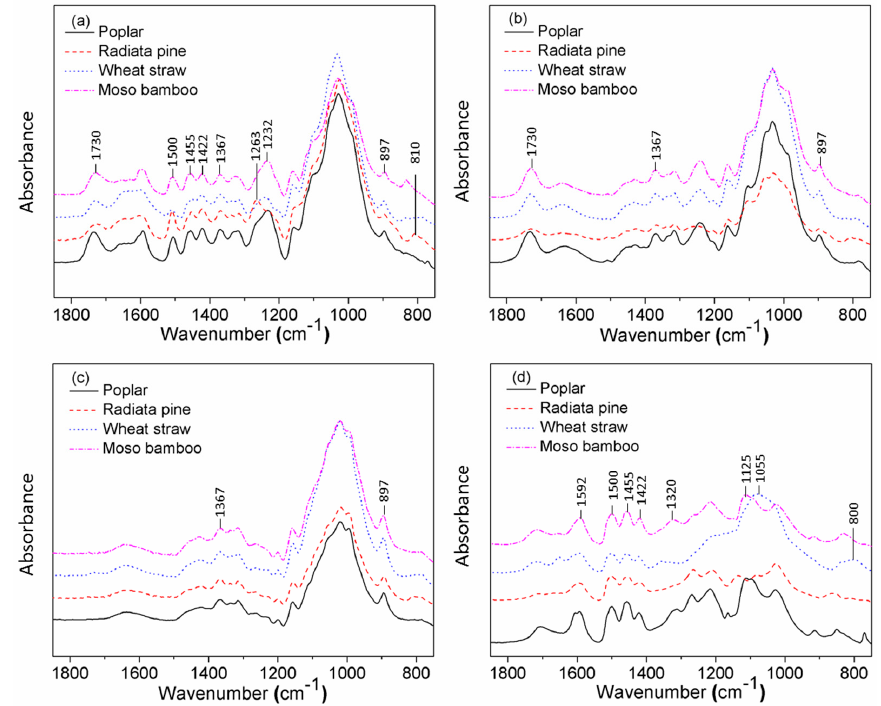
Figure 1. Fourier Transform Infrared (FT-IR) spectra of ( a ) biomass particles and the chemical composites extracted from each particle: ( b ) polysaccharides; ( c ) celluloses; and ( d ) lignins.